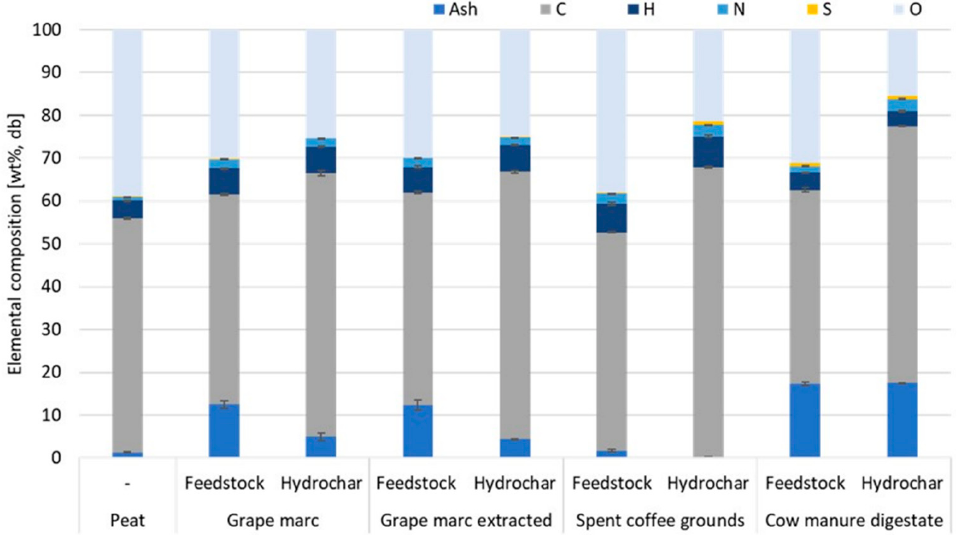
Figure 1. Distribution of ash and macro-element content (wt%, db—dry basis) in peat, HTC feedstock, and resulting hydrochars.